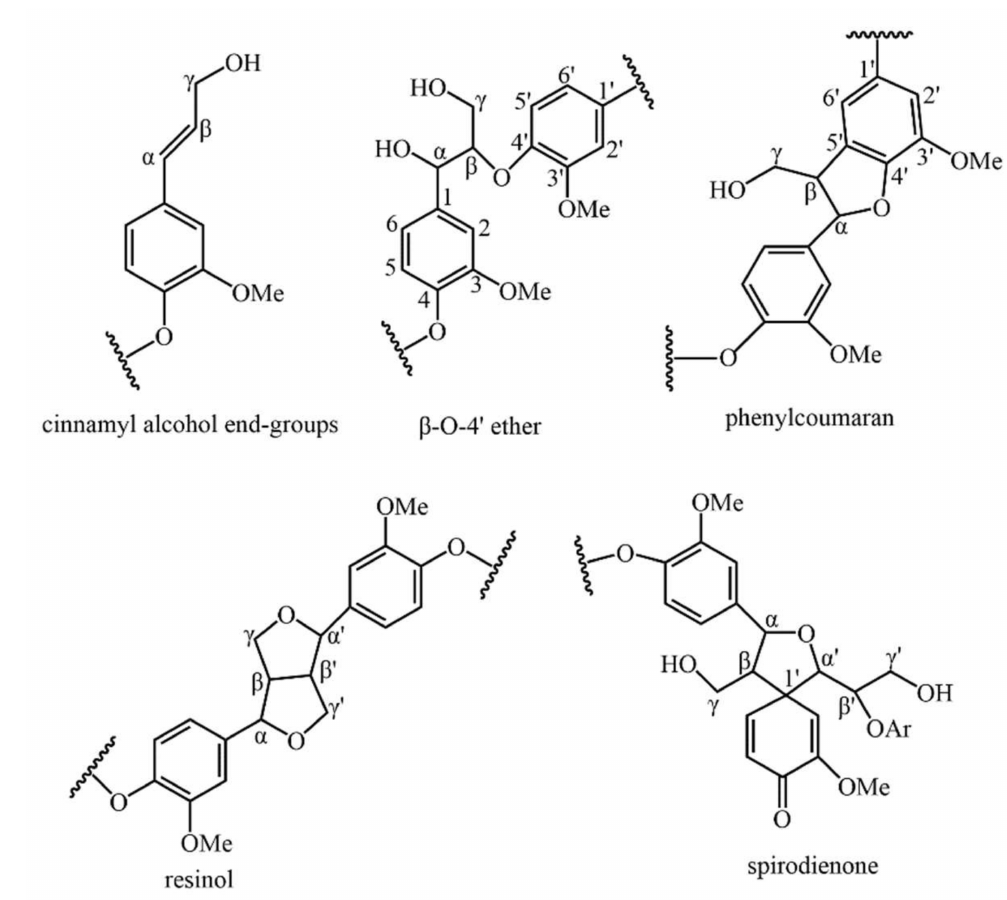
Figure 9. Major linkages between lignin substructural units in Ginkgo CW-DHP.